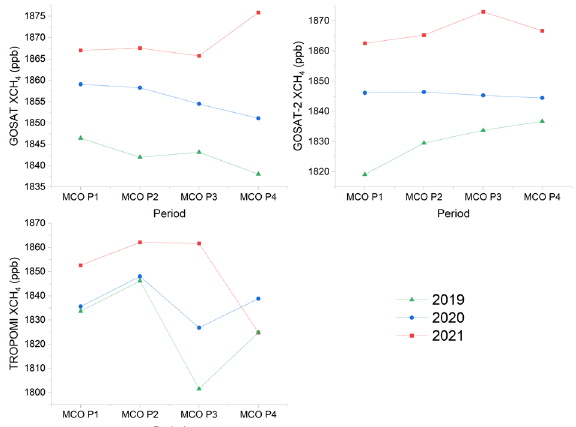
Figure 5. Average XCO 2 and XCH 4 in industrial areas of States during